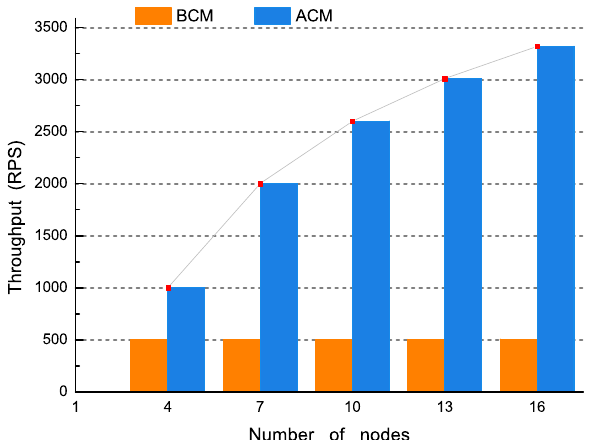
Figure 9. Scaling